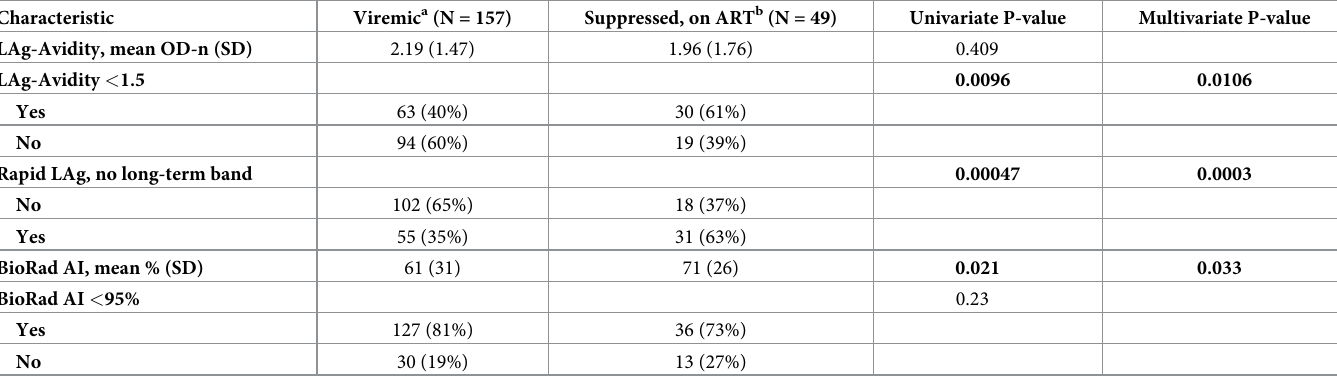
The table compares results obtained with the LAg-Avidity assay, Rapid Lag assay, and BioRad-Avidity assay for viremic seroconverters and seroconverters who were virally suppressed on ART. a Viral suppression was defined as having a viral load � 400 copies/mL.